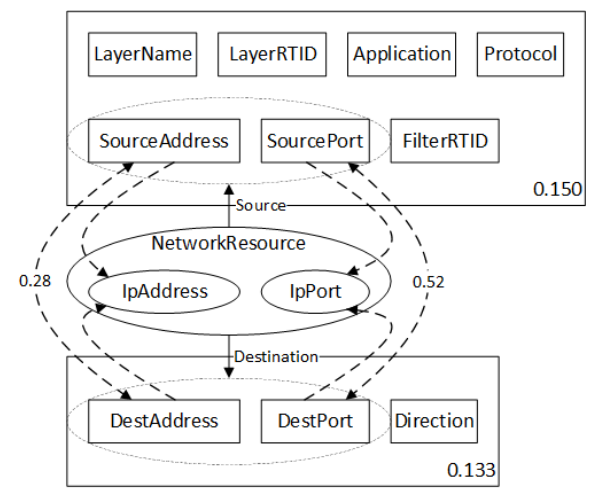
Figure 13. Interconnections between the object types “Source” and